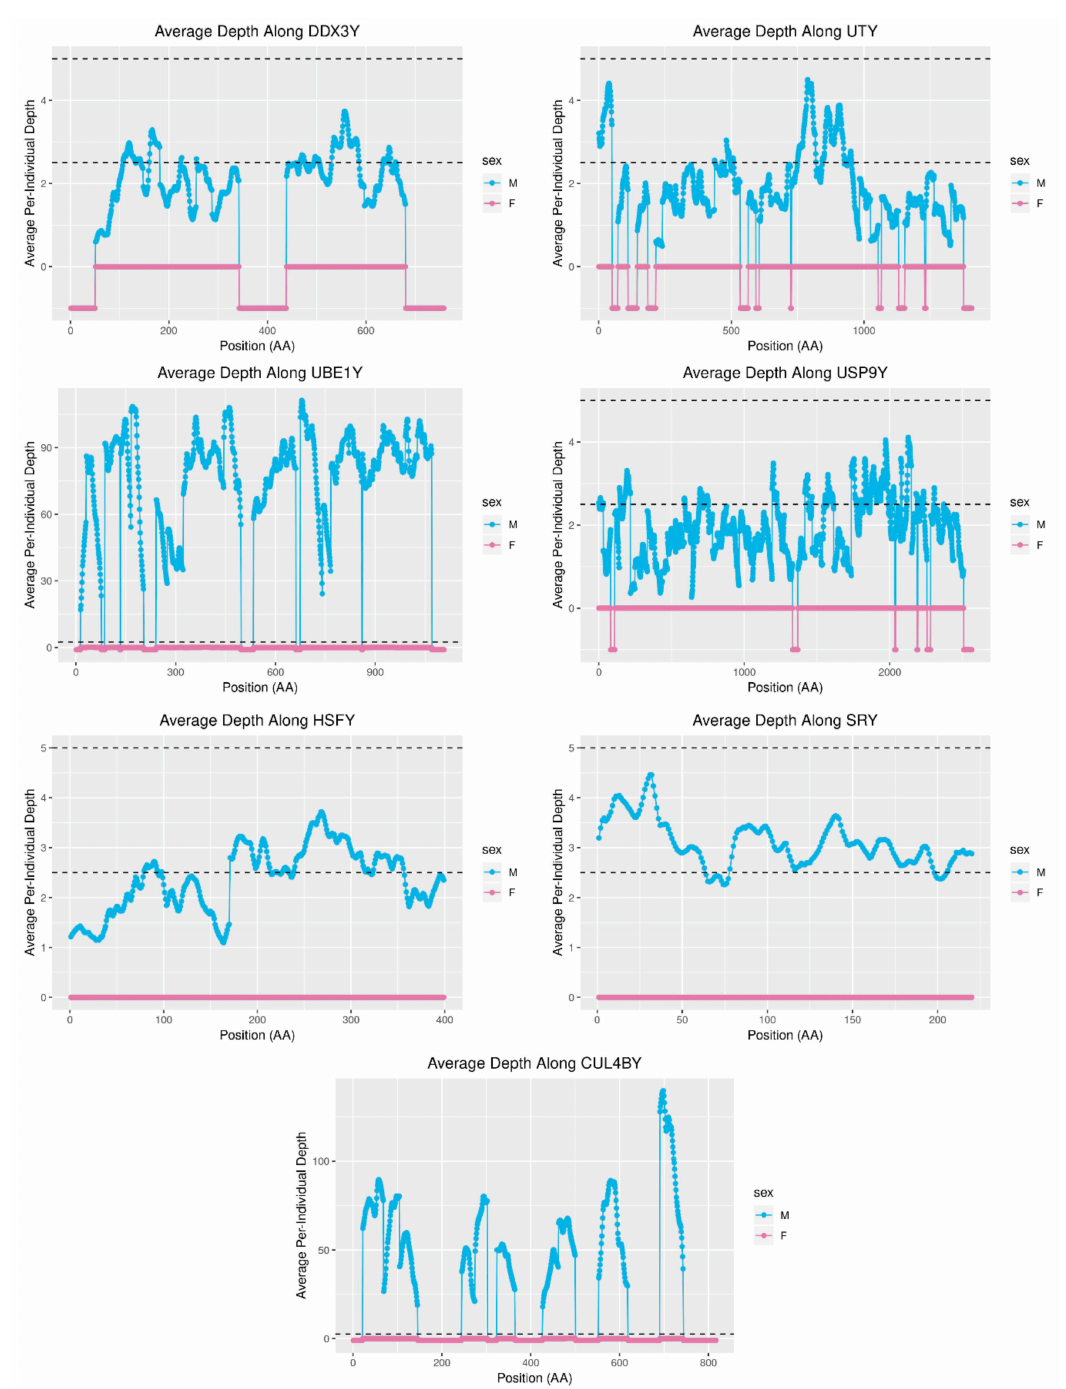
Figure 7. Depth of coverage in the predicted exons of MSY genes. Based on research in dogs and cats [6], DDX3Y , USP9Y , UTY , and UBE1Y (top two rows) were predicted to be single-copy in males, whereas HSFY, SRY , and CUL4BY (bottom two rows) were predicted to be multi-copy in males. The depth of coverage suggests a single copy (as indicated by the lower dotted line) for all of these genes, except UBE1Y and CUL4BY , which appeared to be present at a high copy number. When a codon’s position could not be estimated from the BLAST results, that region of the amino acid is indicated below